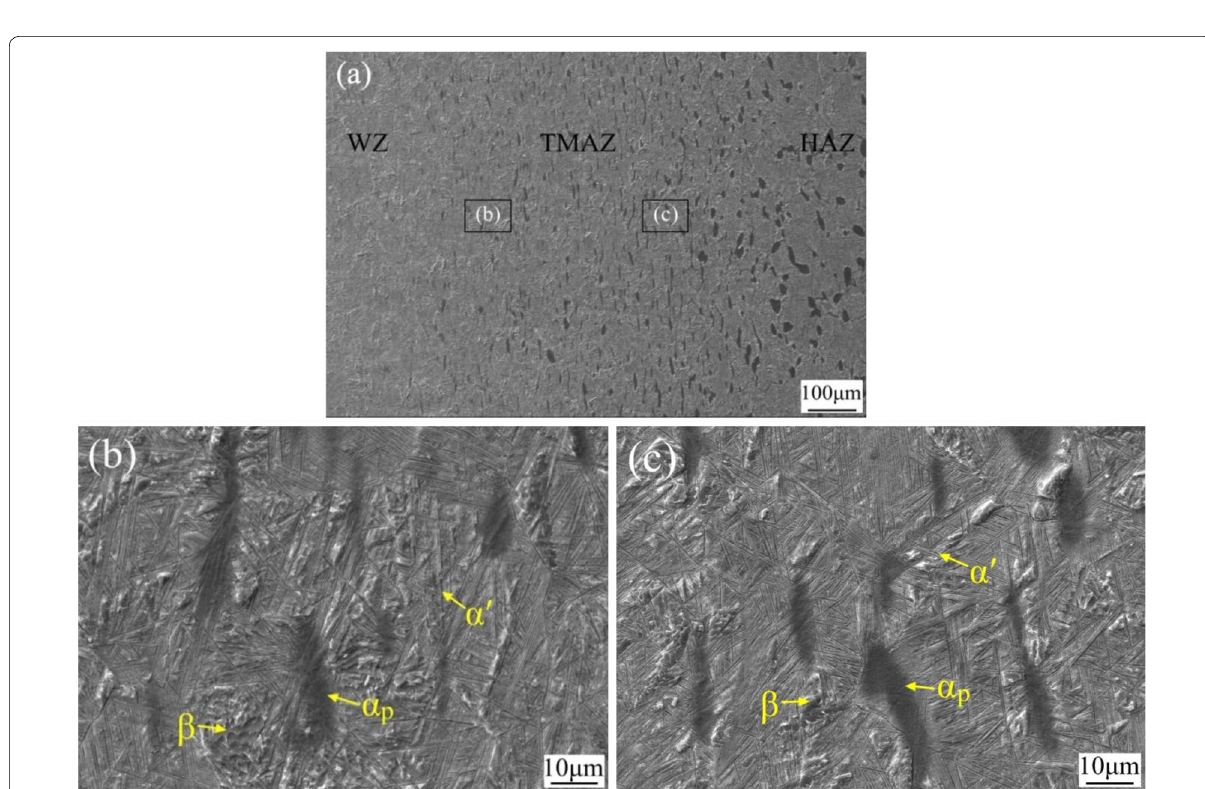
Figure 9 Microstructure characterization of TMAZ of TA19 joint by: a Low magnification of TMAZ; b High magnification of TMAZ close to WZ; c High magnification of TMAZ close to